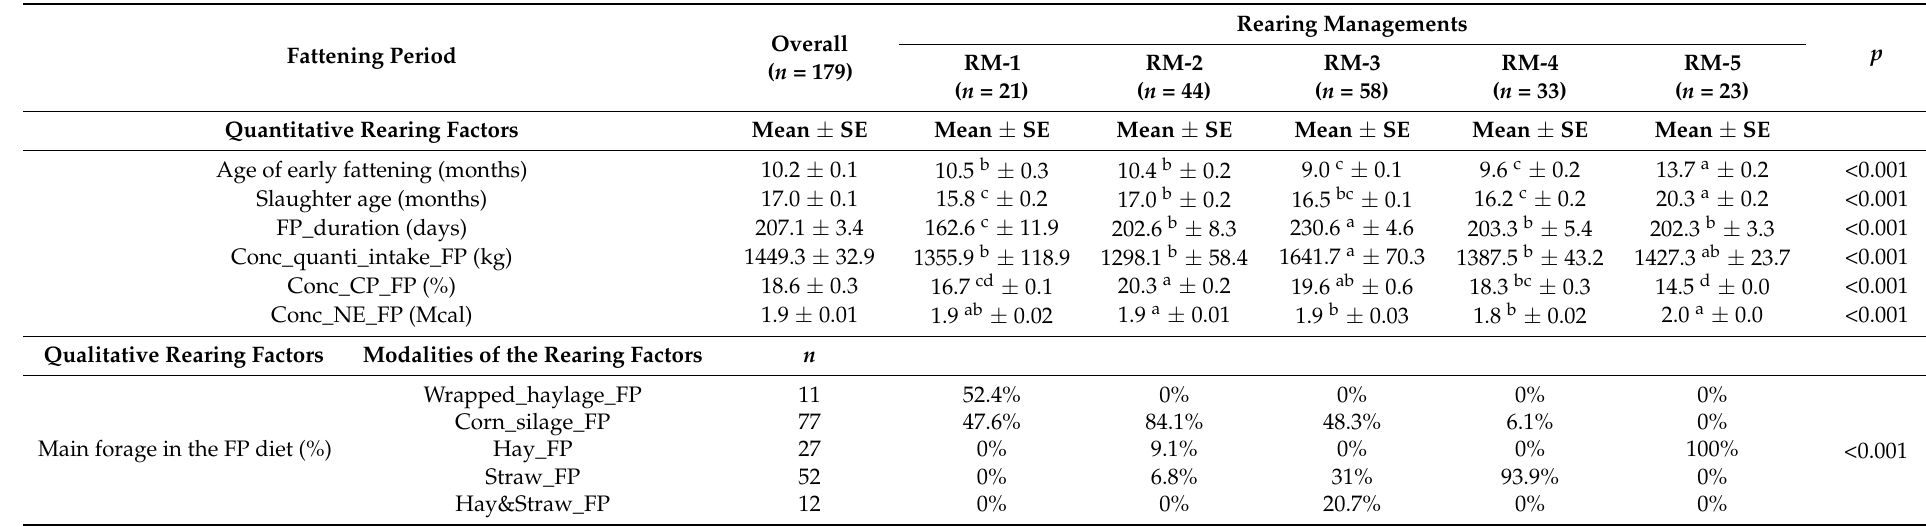
Table 5. Rearing factors characterizing the fattening period (FP) of the rearing managements (RMs) applied throughout the whole life of the young bulls.